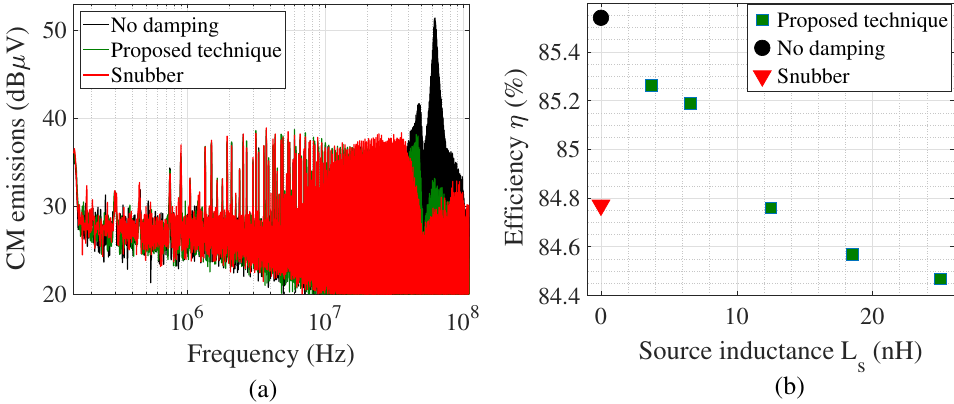
Figure 18. ( a ) CM EMI delivered by the design Buck in case of no damping, snubber inserted and 6.6 nH source inductance, and in ( b ) the conversion